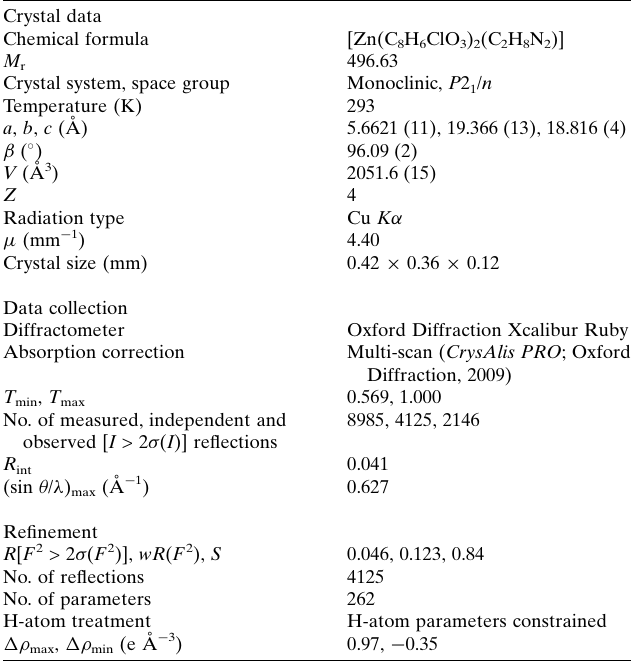
Table 2 Experimental details. Crystal data Chemical